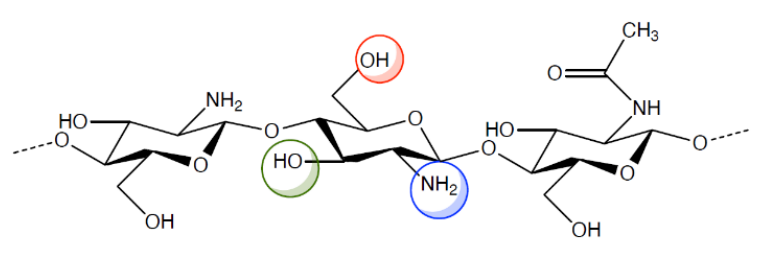
Figure 1. Chemical structure of chitosan and its functional groups.